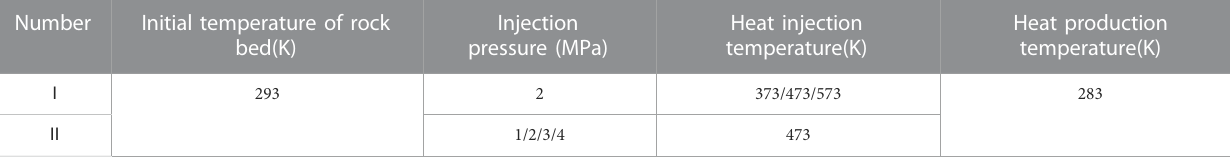
TABLE 2 Numerical simulation